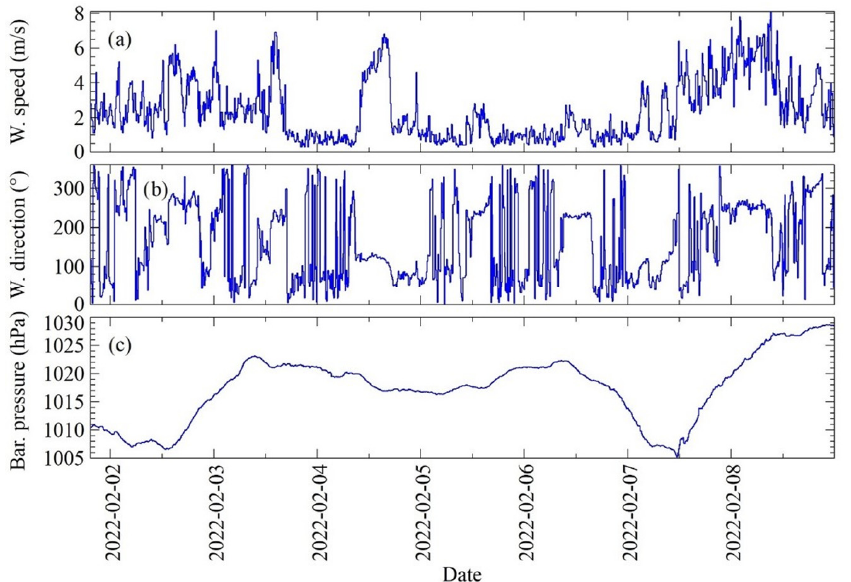
Figure 14. LoRaWAN-obtained observed time series: ( a ) wind speed, ( b ) wind direction and ( c )